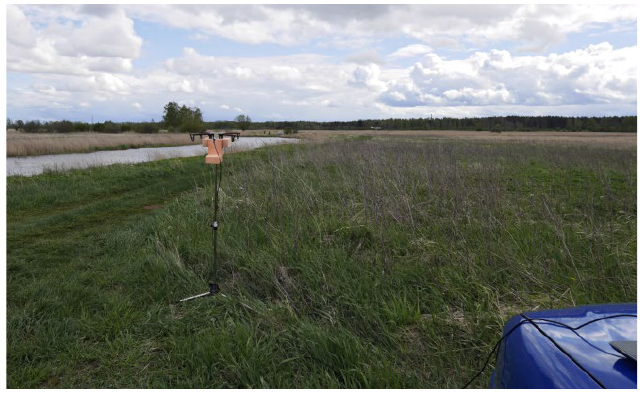
Fig. 3. At 0-degree orientation the longitudinal axes of the drone and the communication module were directed to the